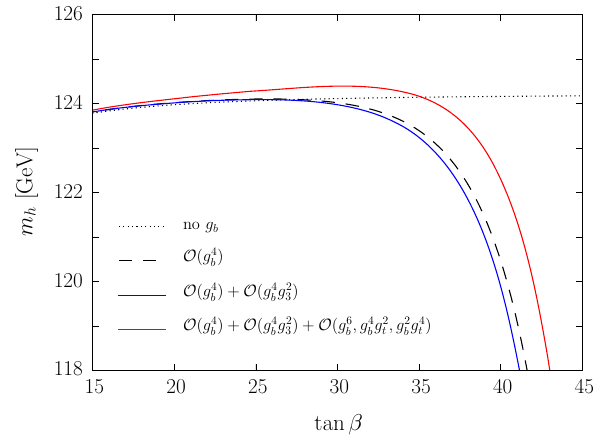
Fig. 2 Predictions for m h as a function of tan β for different imple- mentations of the corrections controlled by the bottom Yukawa cou- pling. We consider an MSSM scenario with all SUSY masses equal to M S = 1 . 5 TeV except m ˜ g = 2 . 5 TeV, and with μ = − 1 . 5 TeV, √ X t = 6 M S and A b = A τ = A t . The meaning of the different curves is explained in the